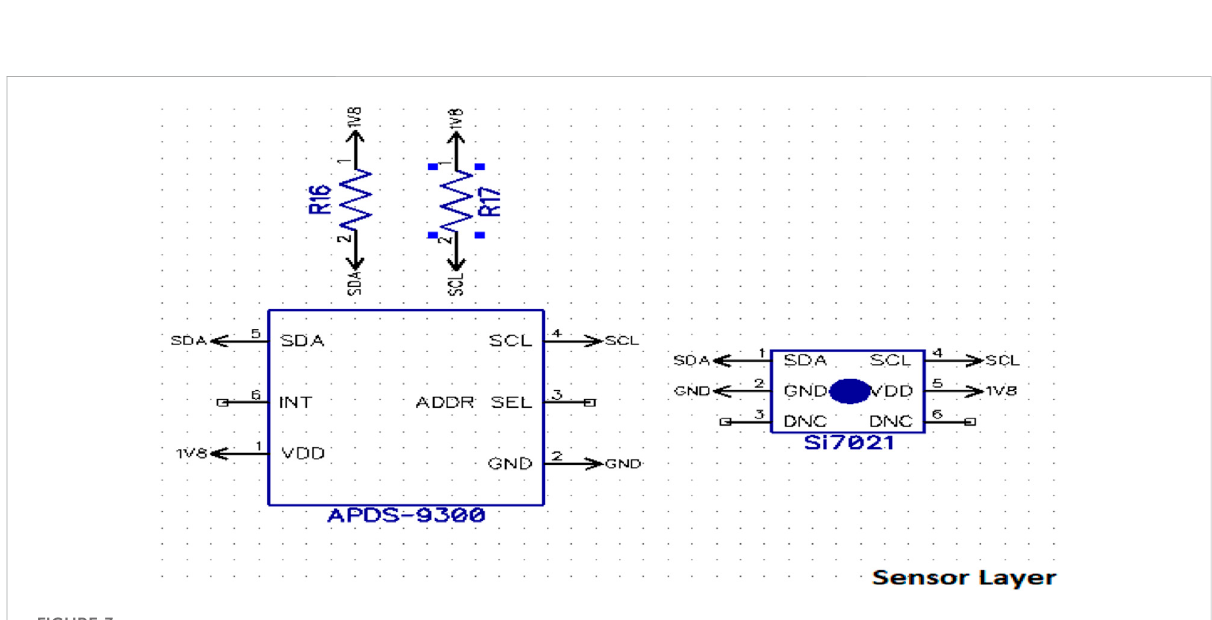
FIGURE 3 Schematic diagram of the end device ’ s sensor